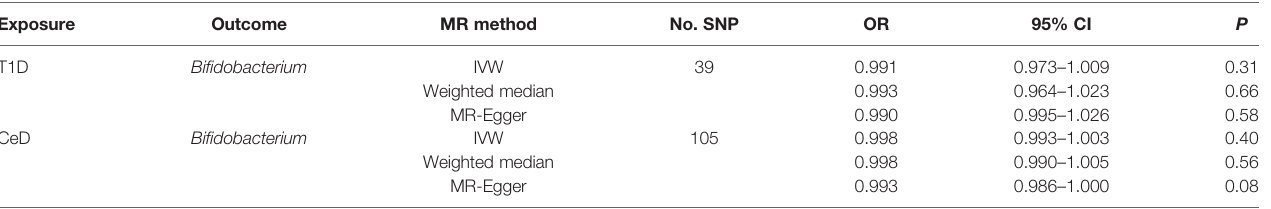
TABLE 4 | Reverse causal association between ADs and gut microbiota. Exposure